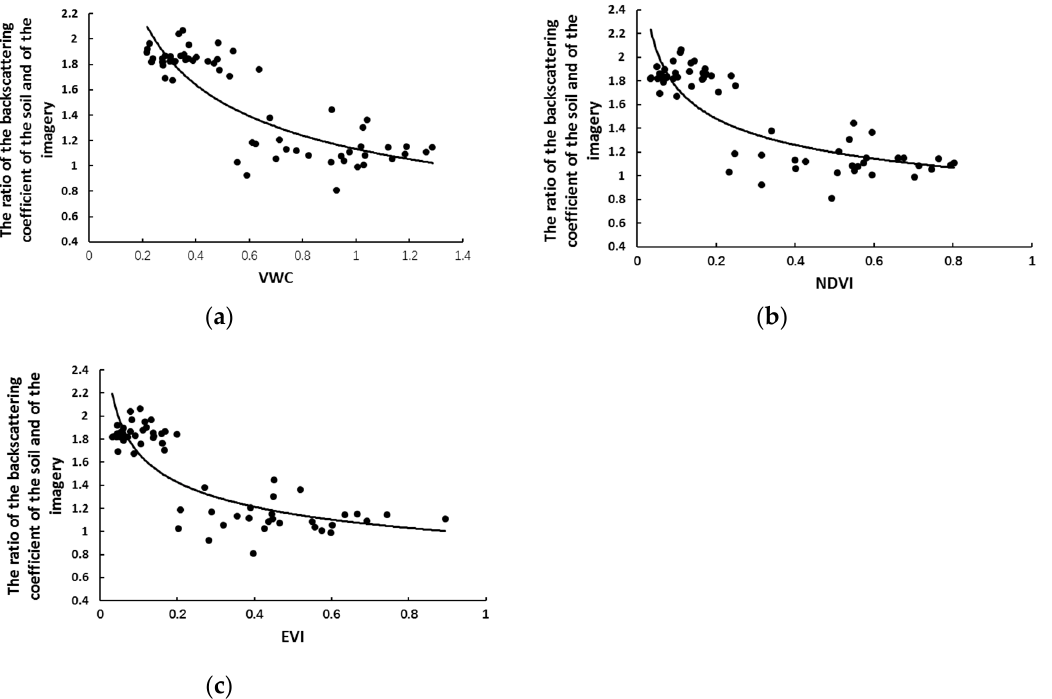
Figure 6. The ratio scatter plots of 𝜎 (cid:3035)(cid:3035)(cid:3046)(cid:3042)(cid:3036)(cid:3039)(cid:3042) /𝜎 (cid:3035)(cid:3035)(cid:3042) to vegetation indices ( a ) VWC; ( b ) NDVI; ( c ) EVI.